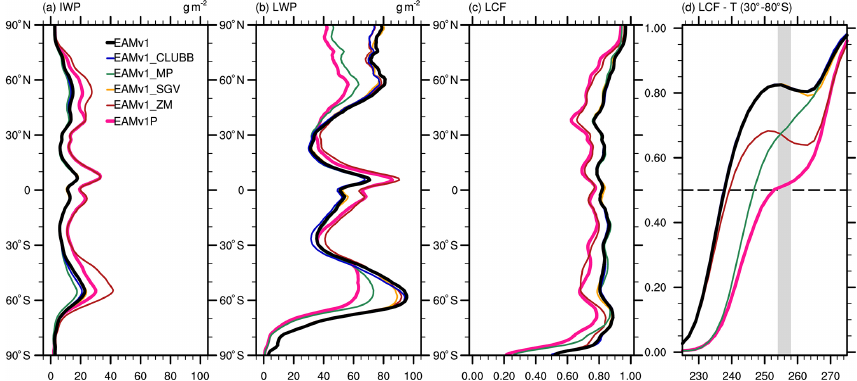
Figure 2. Present-day climatology of (a) mean subgrid vertical velocity variance ( w (cid:48) 2 ; unit = m 2 s − 2 ) at 925hPa in EAMv1. (b) The w (cid:48) 2 difference between EAMv1_CLUBB and EAMv1. (c) The skewness of subgrid vertical velocity (Sk w ≡ (w (cid:48) 3 )/(w (cid:48) The Sk w difference between EAMv1_CLUBB and EAMv1 at 925hPa.